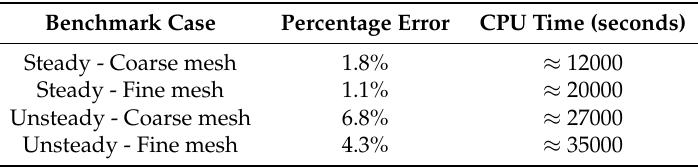
Table 4. Percentage error (with respect to the experimental data) and CPU time of the benchmark cases. All the simulations were run in parallel with four processors. In all cases, the reported CPU time was measured at 8000